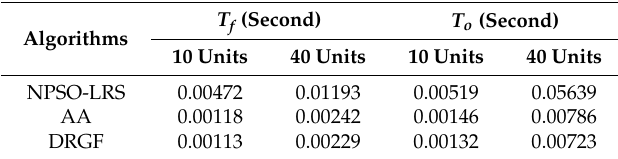
Table 6. The time of T o and T f by adopting different